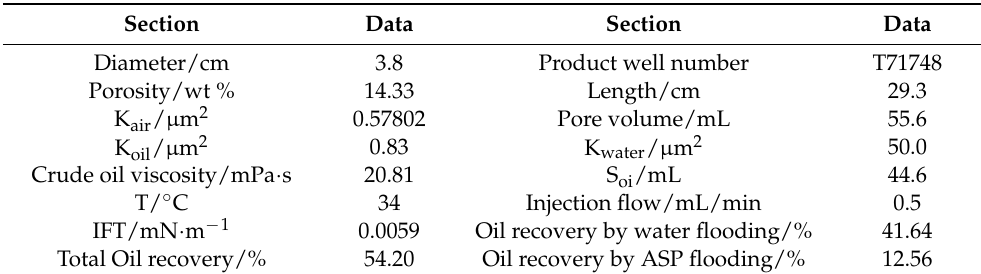
Table 2. Experiment of ASP flooding after water flooding.